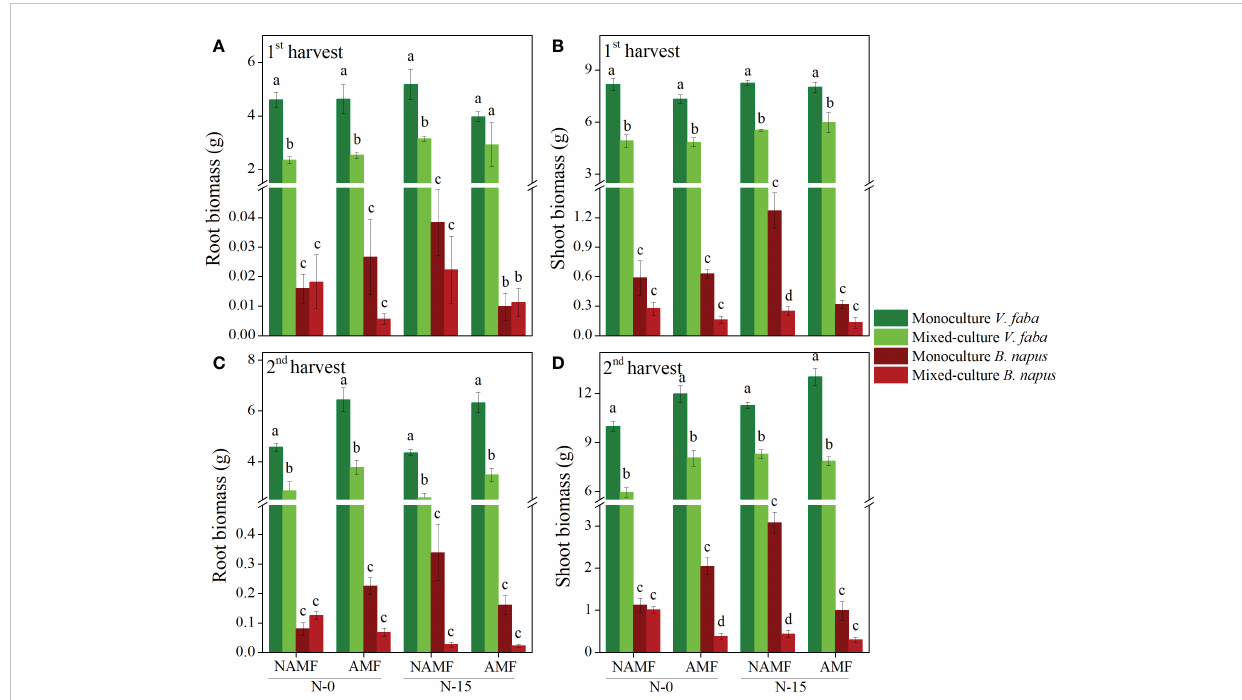
FIGURE 2 Root and shoot biomass production per plant (mean ± SE) in monoculture and mixed-culture V. faba and B. napus under AMF inoculation and N- addition conditions of N-0 and N-15. (A, B) show 1st harvest, (C, D) show 2nd harvest. Different letters denote signi fi cantly different means (Duncan test: P < 0.05).